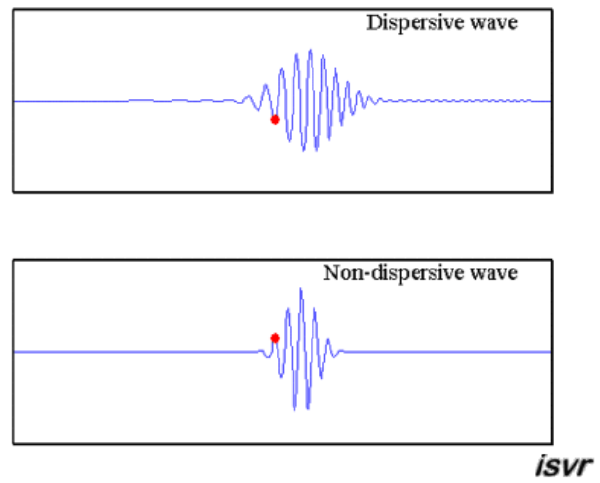
Figure 4. The difference between a dispersive wave packet and a nondispersive wave packet. The latter shows a uniform frequency content, and remains compact as it travels.